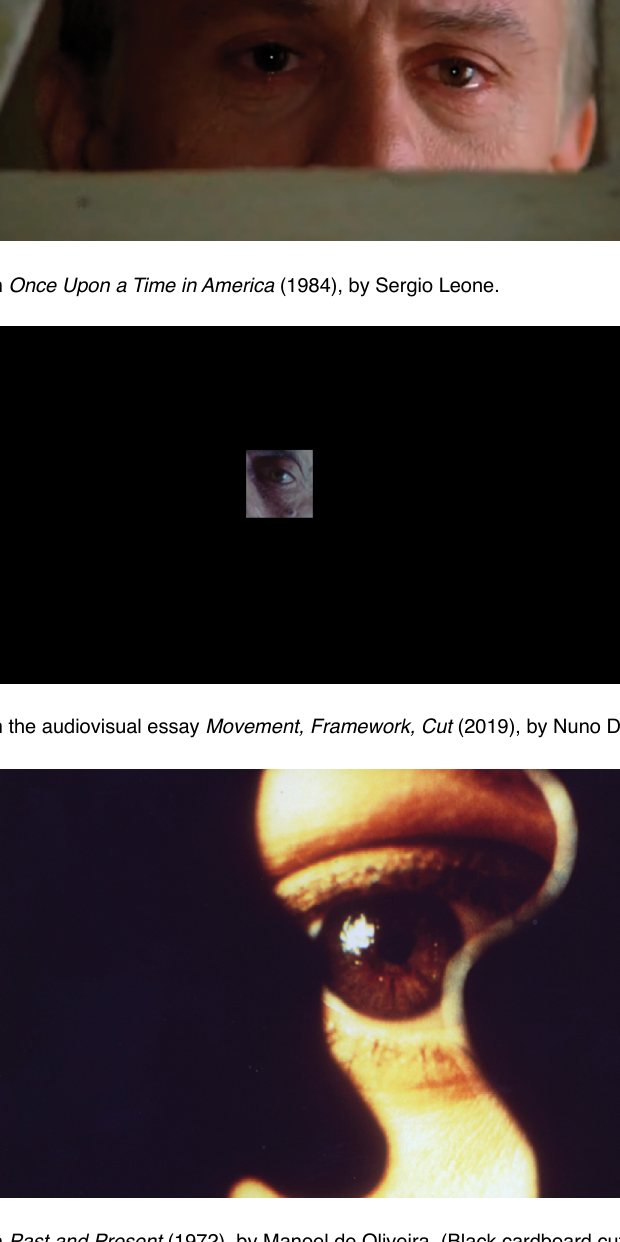
Figure 6 – Still from Past and Present (1972), by Manoel de Oliveira. (Black cardboard cut to look like a door